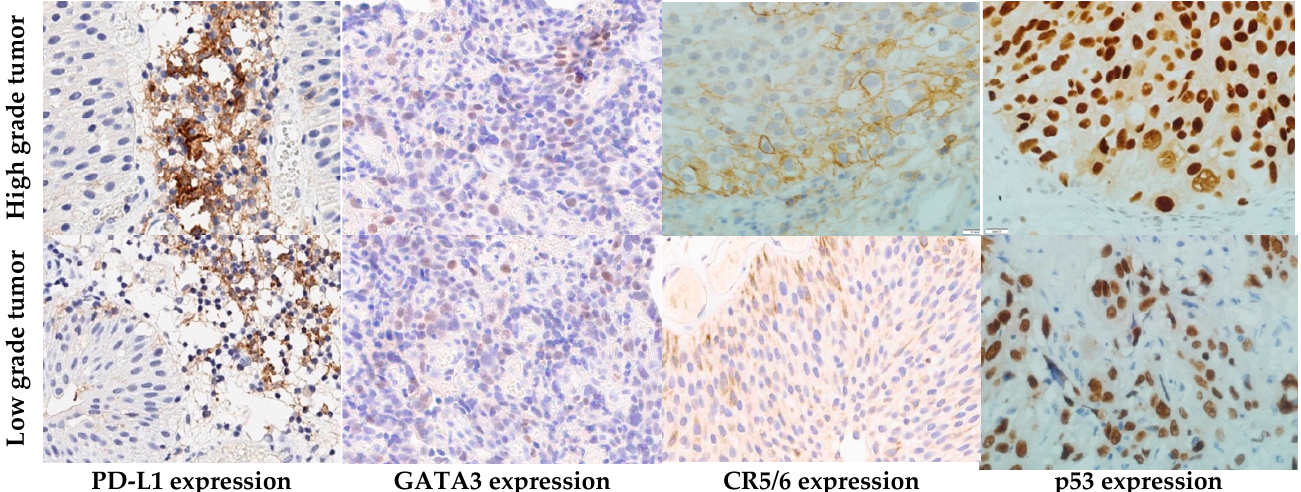
Figure A1. Immunohistochemical profile of the engrafted high- and low-grade double-negative noninvasive bladder tumors: anti-PD-L1, anti-GATA3, anti-CR5/6, and anti-p53 IHC staining, x500.